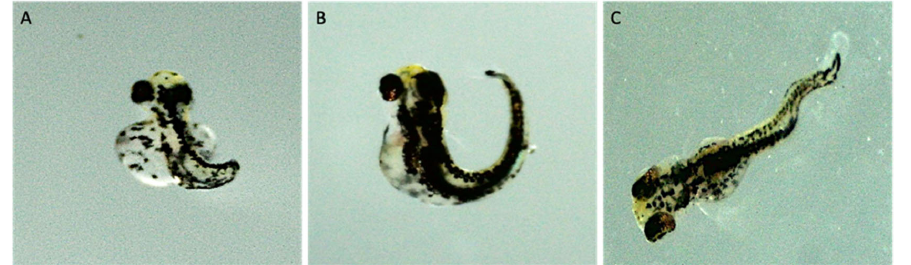
Figure 3. Anomalies observation of D. rerio larvae exposed to 20 mg/L 50 nm nPS ‐ NH 2 under a stereomicroscope. ( A ) Malformation of entire body and lack development of the tail; ( B , C ) curvature of the tail.